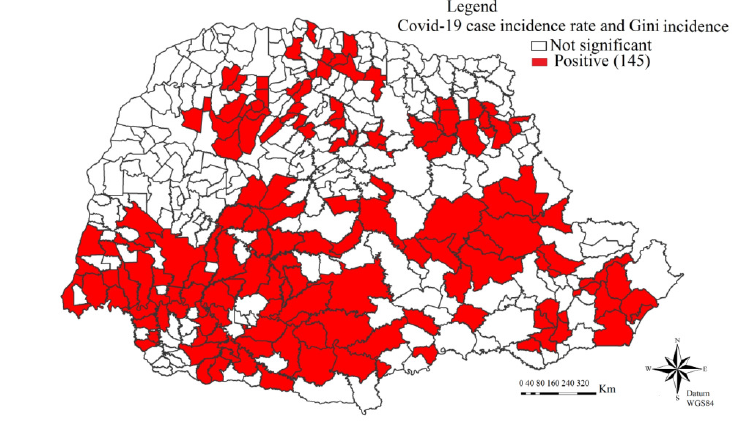
Figure 5. Map of the spatial correlation between the incidence rate of the number of confirmed cases for COVID-19 and the Gini index using the multivariate Geary local index ( C M